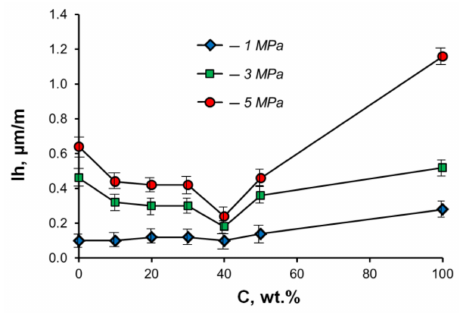
Figure 2. Effect of tin content ( C ) on the wear intensity ( Ih ) of sintered Al–Sn alloys at different pressures under dry friction against steel. Sliding speed is 0.6